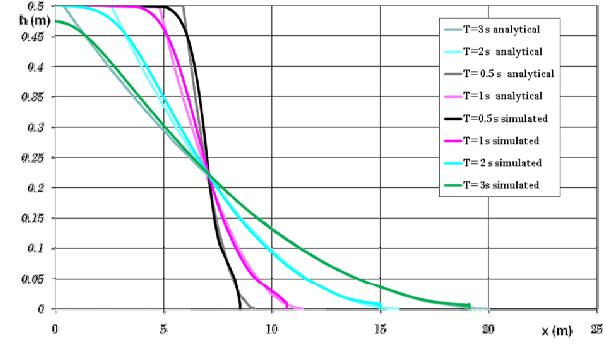
Fig. 1. Comparison between numerical and analytical data (Whitham, 1974) for a dam-break in a 20m-long straight